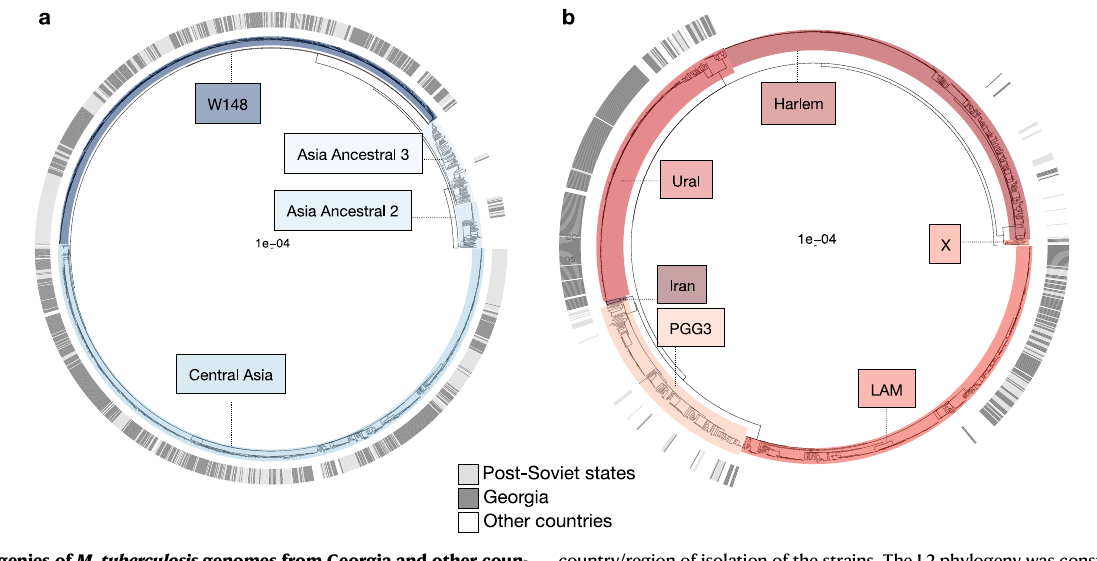
country/region of isolation of the strains. The L2 phylogeny was constructed from 23,616 variable nucleotide positions and the phylogeny of L4 strains was con- structed from 27,066 variable nucleotide positions. Scale bars indicate substitu- tions per